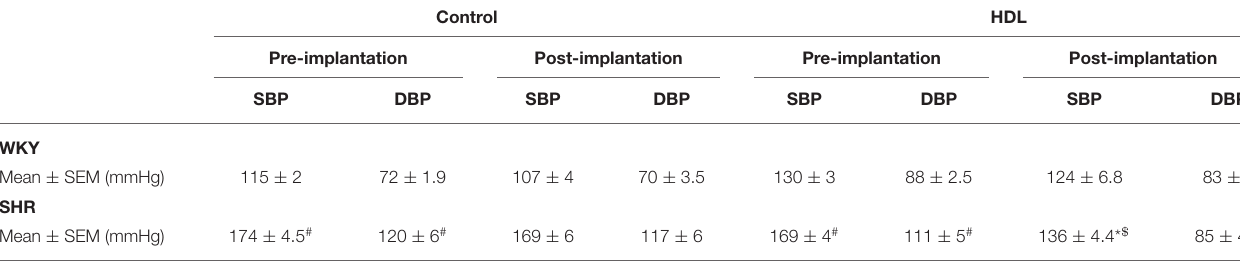
TABLE 1 | Blood pressure measurements of WKY and SHR treated with or without HDL. Control HDL Pre-implantation Post-implantation Pre-implantation Post-implantation